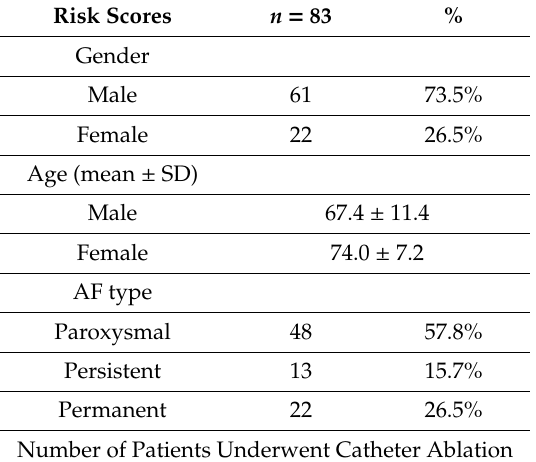
Table 1. Characteristics of atrial fibrillation (AF) patients subjected to miRNA